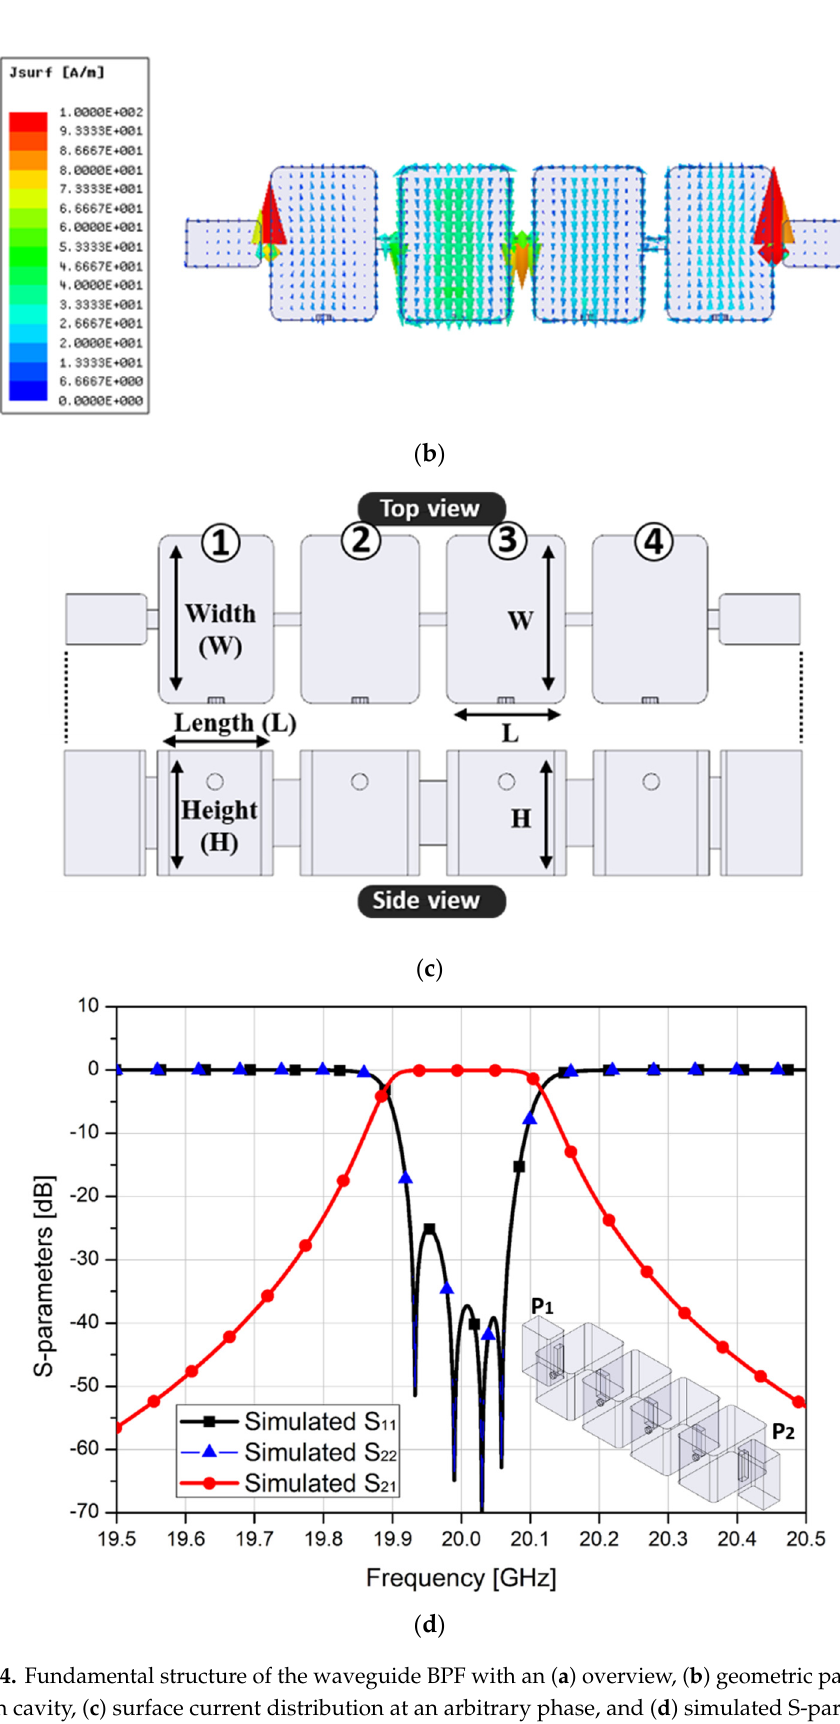
Figure 4. Fundamental structure of the waveguide BPF with an ( a ) overview, ( b ) geometric parameters for each cavity, ( c ) surface current distribution at an arbitrary phase, and ( d ) simulated S-parameters.